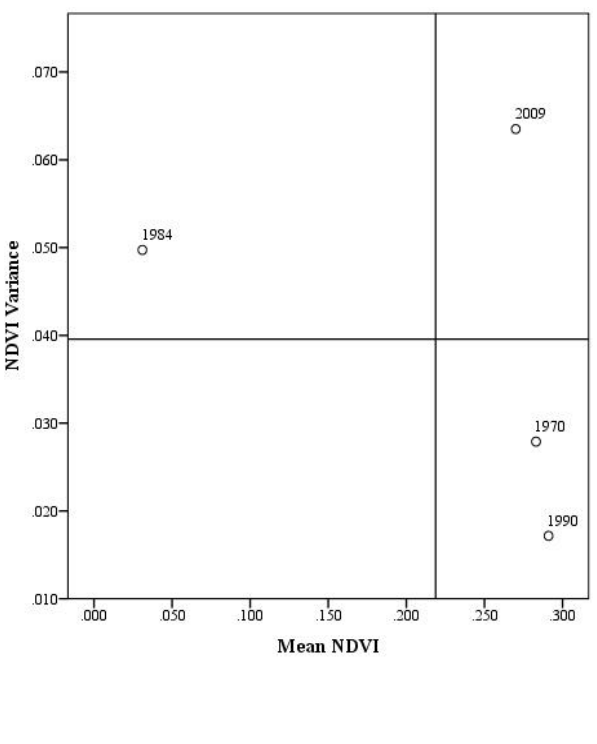
Figure 6. Results from mean variance analysis for the entire landscape, with each dot representing one image date, as